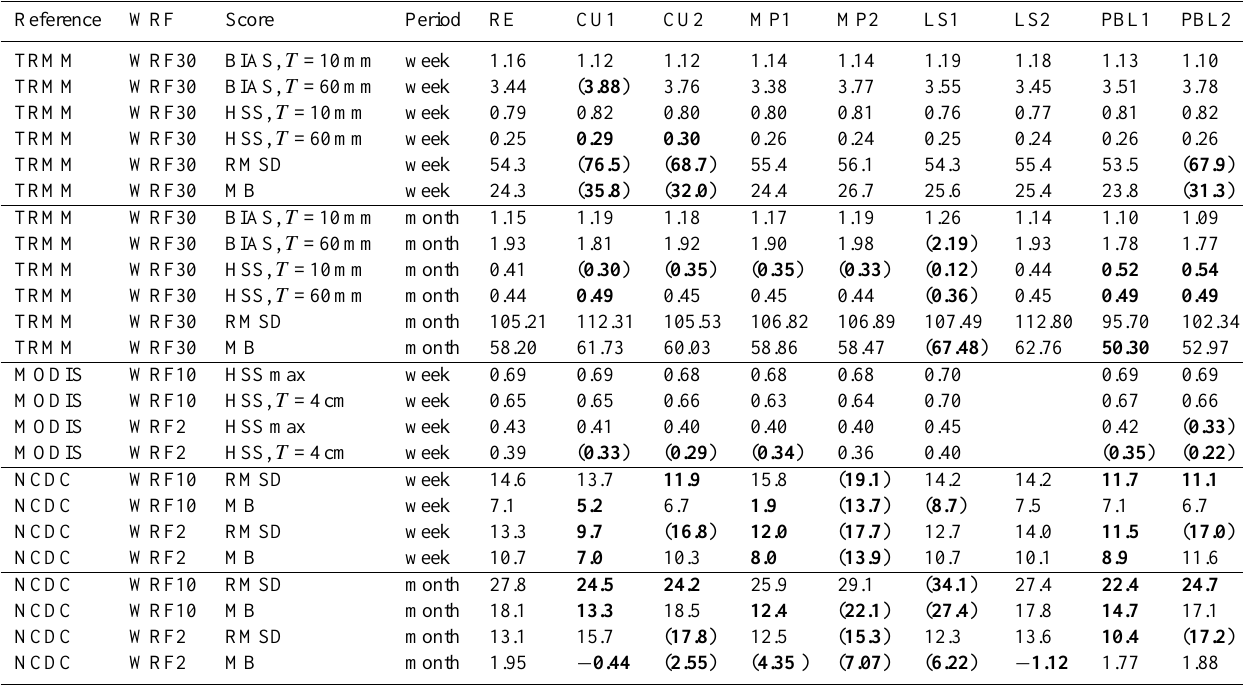
Fig. 8. Sensitivity to the forcing strategy. Left: one-week precipitation (mm/week) for TRMM, WRF30–RE, WRF30–WI and WRF30–WIN over a subset of the LD. Right: daily HSS curves from WRF30 with respect to TRMM for the 1 mm/day precipitation threshold over the same subset. Table 6. Scores used for statistical evaluation of the reference and the eight PPS experiments. The scores that differ of more than 10% from the RE are marked in bold, and put between parentheses if they have a lower skill than the RE.